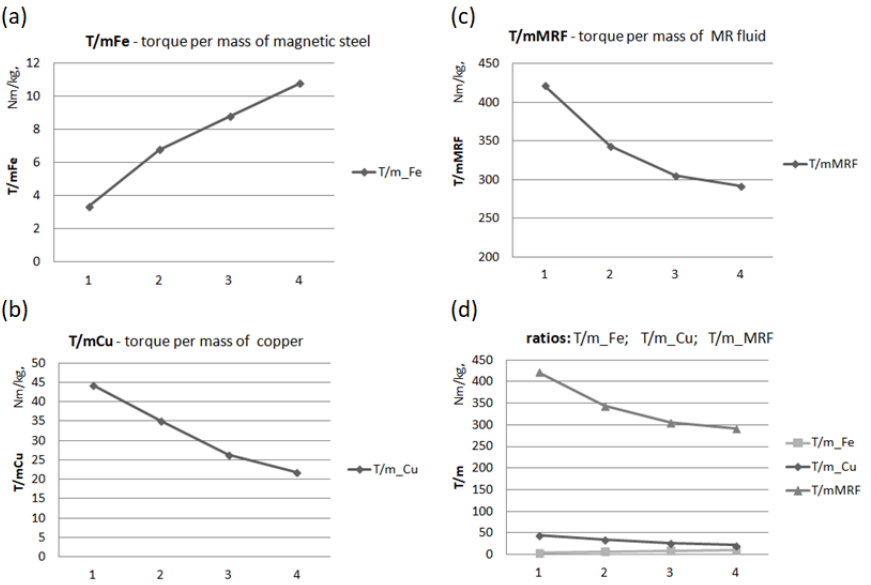
Figure 17. Torque per magnetic steel mass ( a ), torque per copper mass ( b ), torque per MR fluid mass ( c ) and the complete set of charts ( d ).